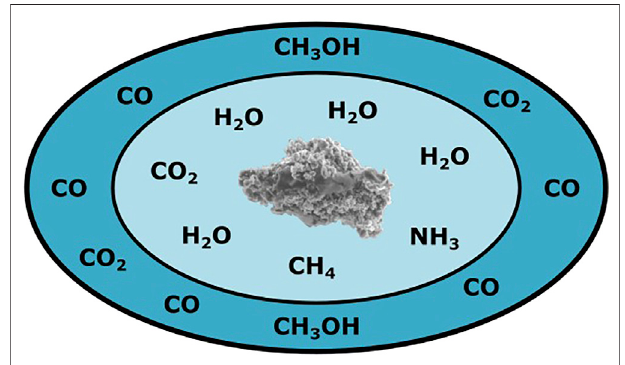
FIGURE 2 | Median structure of icy grain mantles within dense interstellar clouds. Shown in the image, a diagram (not to scale) of a typical icy mantle divided into two zones: a lower polar layer rich in H 2 O molecules and hydrogenated heteroatoms, and an upper apolar layer largely consisting of CO and related molecules. More detailed information can be found in the work of Öberg